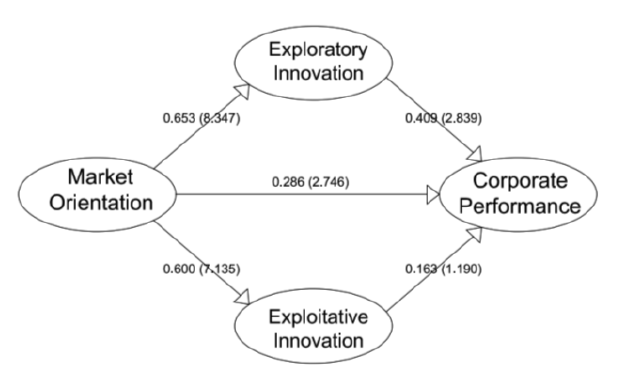
Figure 1: The Path Diagram of The Structural Model